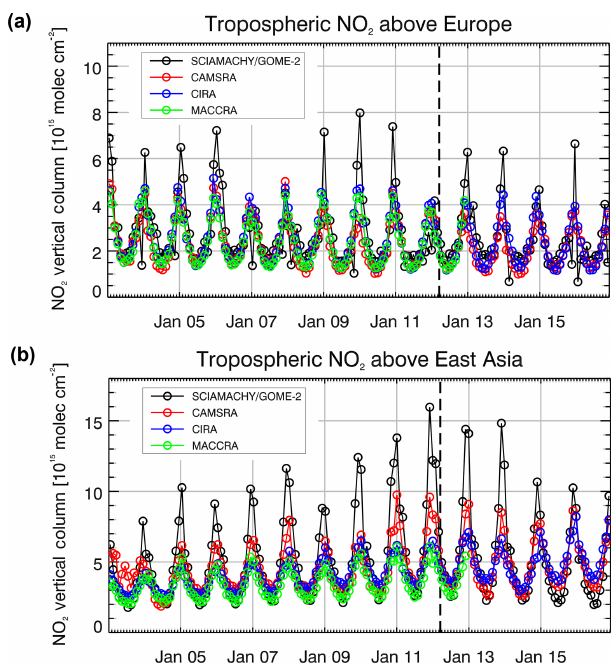
Figure 18. Time series of tropospheric column NO 2 from the three reanalyses and IUB tropospheric NO 2 retrievals in 10 15 moleccm − 2 averaged over (a) Europe and (b) East Asia. CAMSRA is shown in red, CIRA in blue, MACCRA in green and the observations in